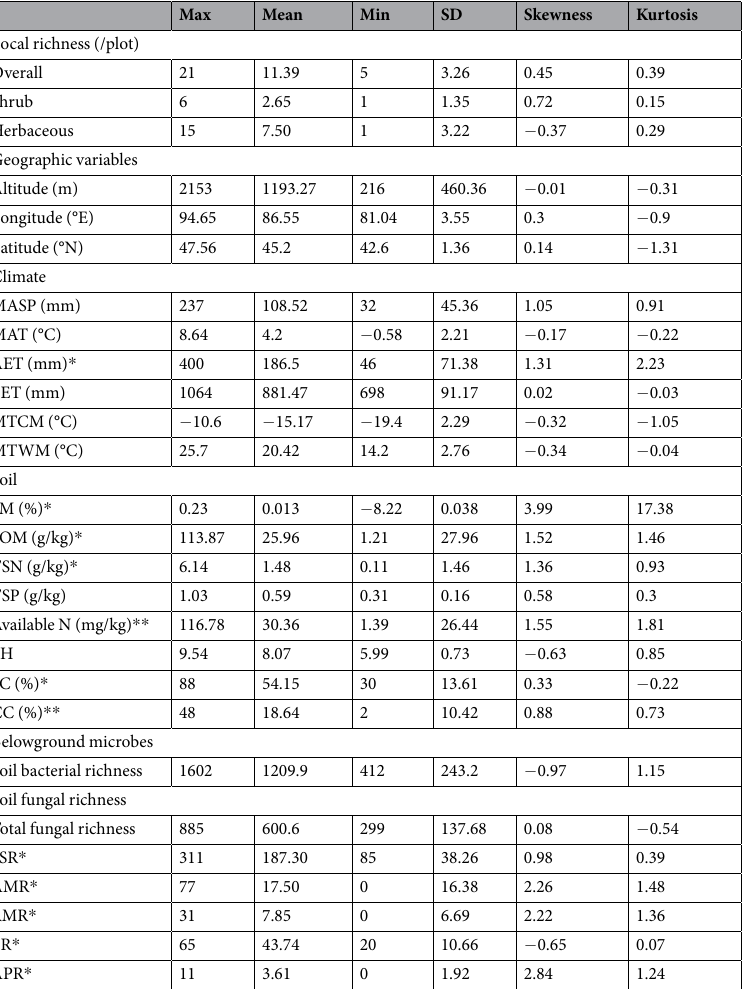
Table 1. Descriptive statistics of LPSR and environmental factors in our study. Some factors were square root (